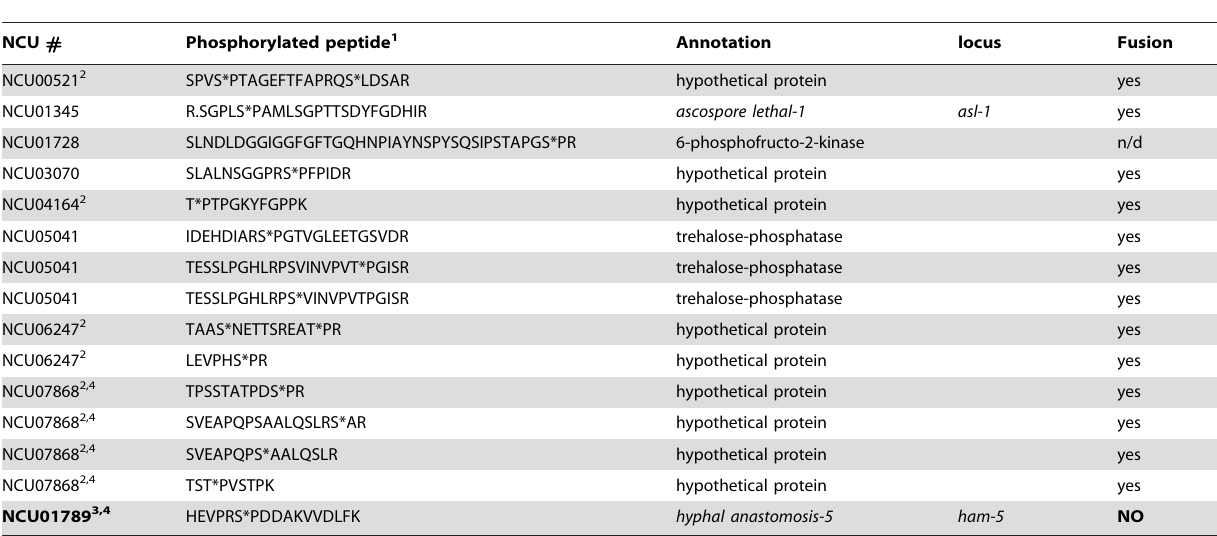
Table 1. Phosphopeptides with predicted MAPK site that showed decreased abundance in 1NM-PP1-treated mak-2 Q100G